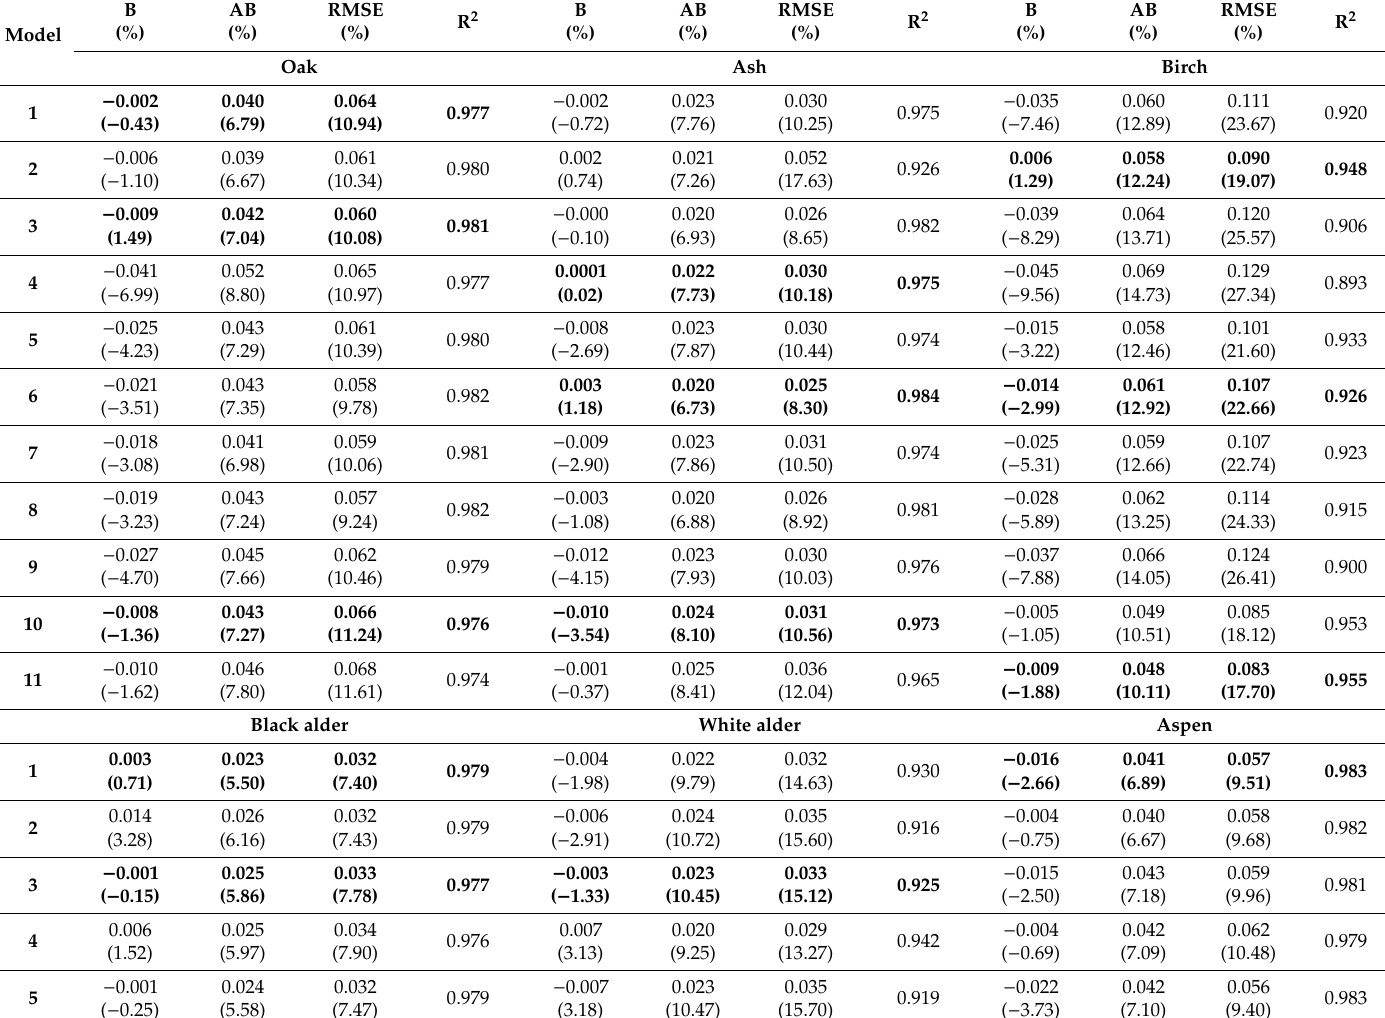
Table 3. Statistical measures for all of the validated volume models